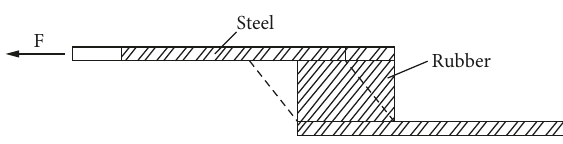
Figure 1: Pure shear test rubber specimen force mode.